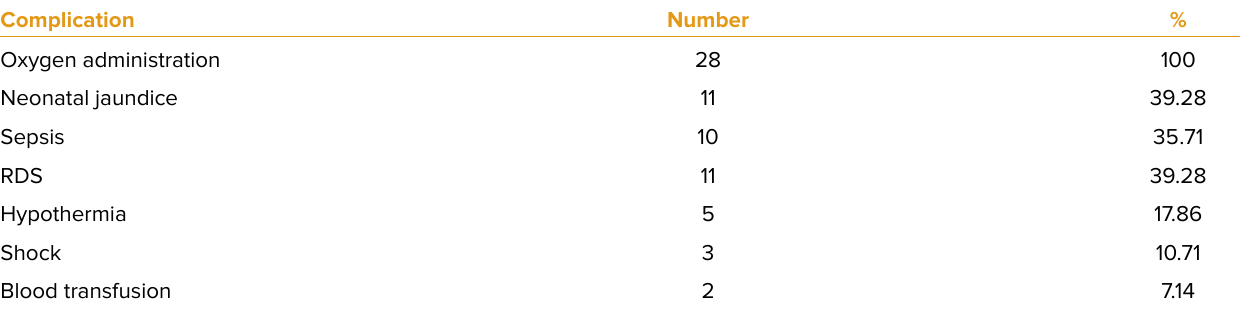
Table 1. Number of babies with different complications